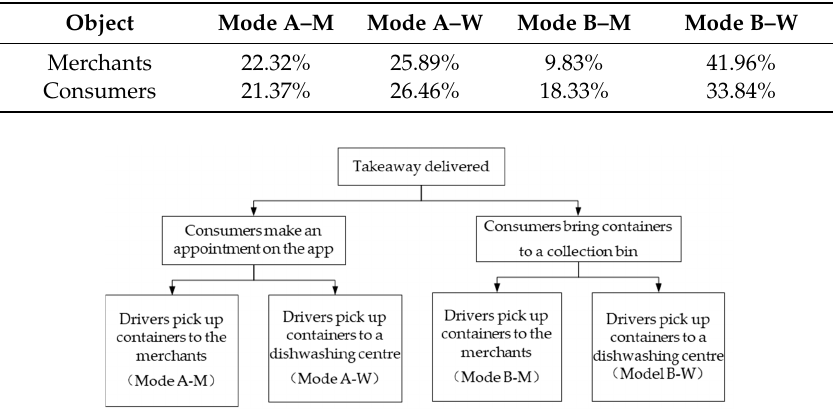
Table 2. The preferences of the second-round modes.